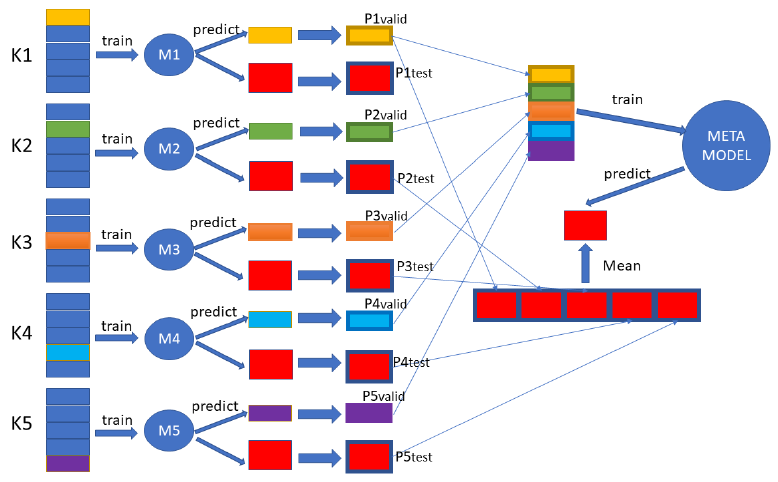
Figure 5. Out-of-fold prediction process.